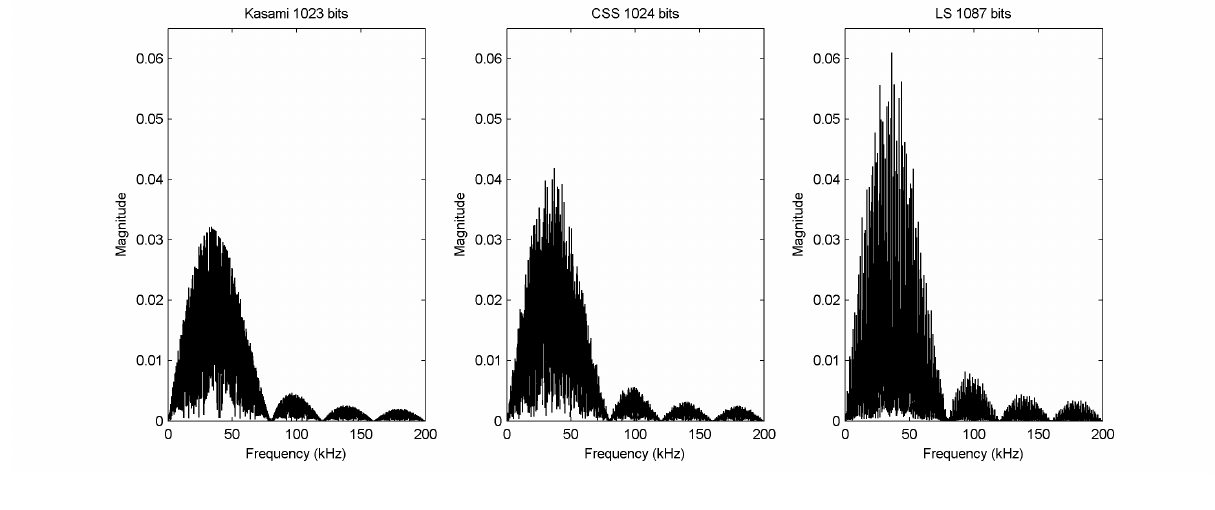
Figure 1. Spectral features of the longest BPSK modulated